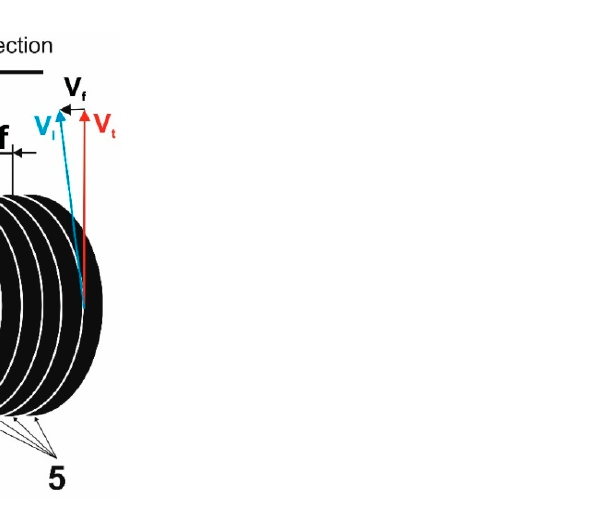
Figure 1. The scheme of laser-alloying by re-melting: 1—laser beam; 2—molten pool; 3—specimen (Inconel ® 600-alloy); 4—pre-coated paste with alloying material; 5—the multiple laser tracks; v f —feed rate; v l —scanning rate; v t —tangential speed; n —rotational speed; f —distance between the axes of adjacent tracks.